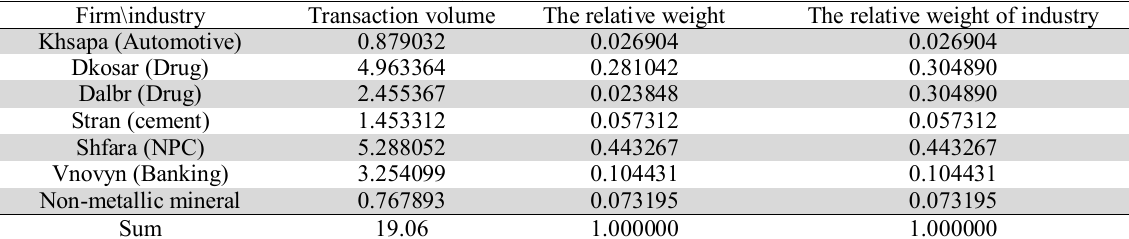
The summary of the results of our survey Firm\industry Transaction volume The relative